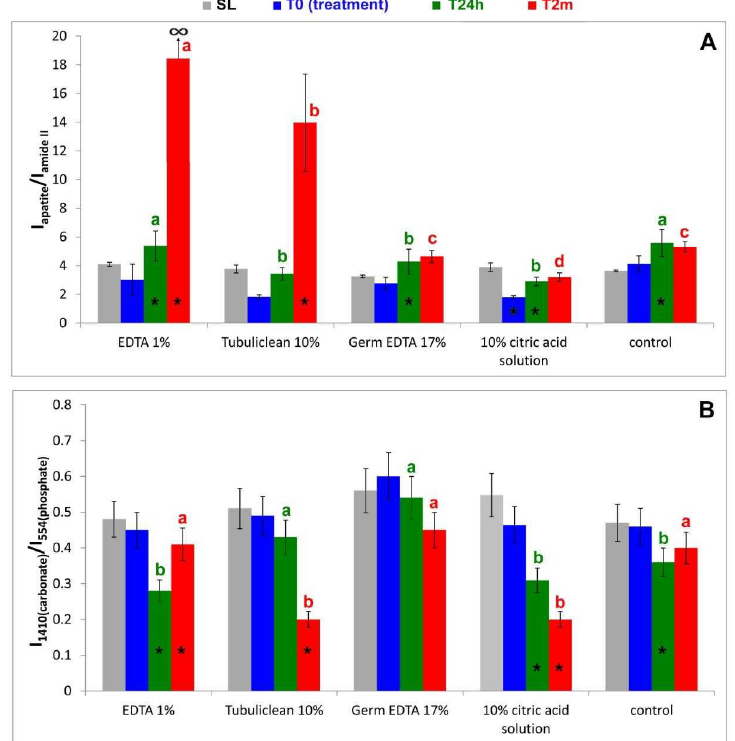
Figure 11. Values of the I apatite/ I amide II ( A ) and I1410(carbonate)/I554(phosphate) ( B ) ratios (average ± standard deviation), as calculated from the IR spectra recorded on the dentin surfaces under study, submitted to sanding (SL, grey), treatment with 1% EDTA, 10% EDTA (Tubuliclean 10%), 17% EDTA (Germ EDTA 17%), 10% citric acid solution, or water (blue), aging in SBF for 24 h (T24h, green) and two months (T2m, red). The asterisks on the histogram bars indicated significant differences with respect to the value observed in the previous step of the study within the same treatment. Identical letters represent no statistical differences ( P ≥ 0.05) among tested solutions at T24h or